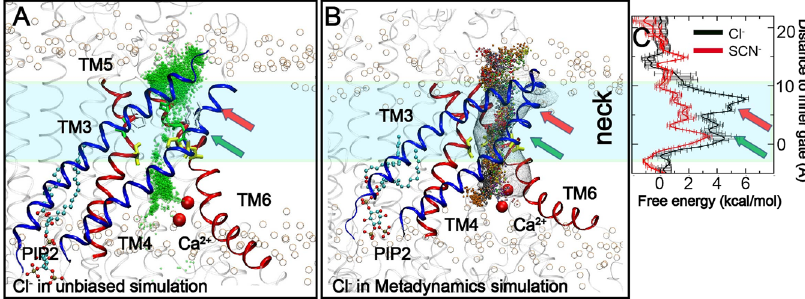
Fig. 4 Pathway and free energy pro fi les of Cl − permeation through TMEM16A CaCC. A Positions of Cl − (green beads) during a spontaneous permeation event (0.73 – 1.14 μ s, sim 3 ), overlaid onto the snapshot of the channel sampled at 1.0 μ s of the same trajectory. B Positions of permeating Cl − during metadynamics simulations, overlaid onto the initial structure of metadynamics simulations. The Cl − ion is presented as beads and different colors represent different permeation events. TMs 3 – 4 are represented as blue cartoons and TMs 5 – 6 as red cartoons. The rest of the protein is presented as transparent cartoons. The phosphate atoms in lipid head groups are represented as transparent spheres. The pathway predicted by HOLE is shown as a transparent mesh for reference in panel B . C Free energy pro fi les of Cl − (black trace) and SCN − (red traces) permeation through the predicted open state of TMEM16A CaCC calculated from umbrella sampling. The error bars were estimated as the difference between results calculated using the fi rst and second halves of the